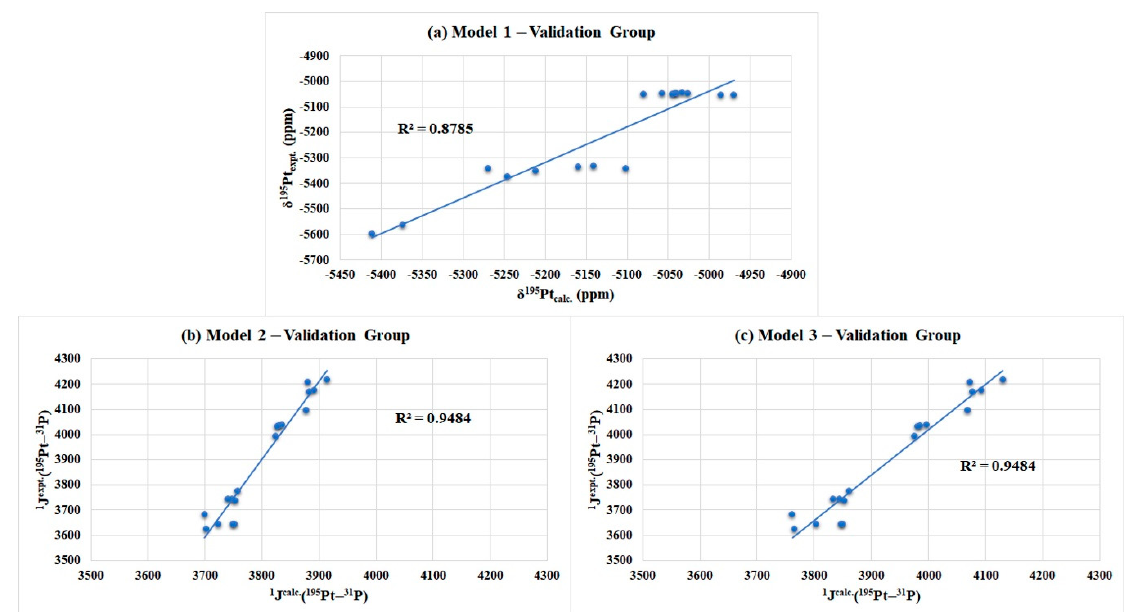
Figure 3. Correlation between the calculated and experimental values for the validation group of the models. ( a ) δ 195 Pt for the set of 17 Pt(0) complexes (Model 1); ( b ) 1 J( 195 Pt– 31 P) for a set of 18 coupling constants in 9 trigonal-planar Pt(0) complexes (Model 2); and ( c ) 1 J( 195 Pt– 31 P) for a set of 18 coupling constants in 9 trigonal-planar Pt(0) complexes (Model 3).